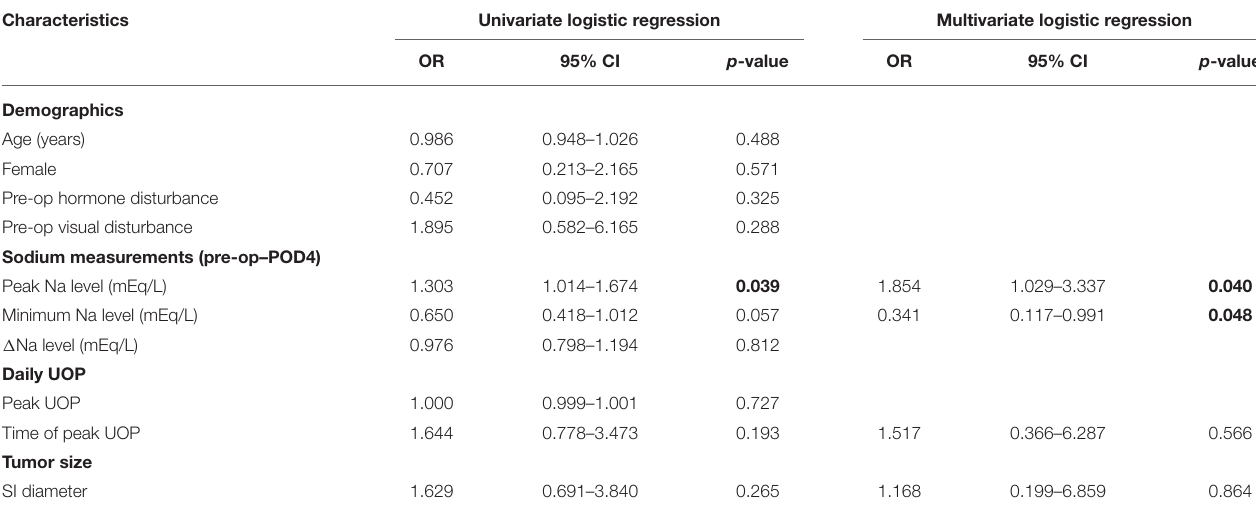
TABLE 3 | Logistic regression model of requiring desmopressin prescription at discharge.